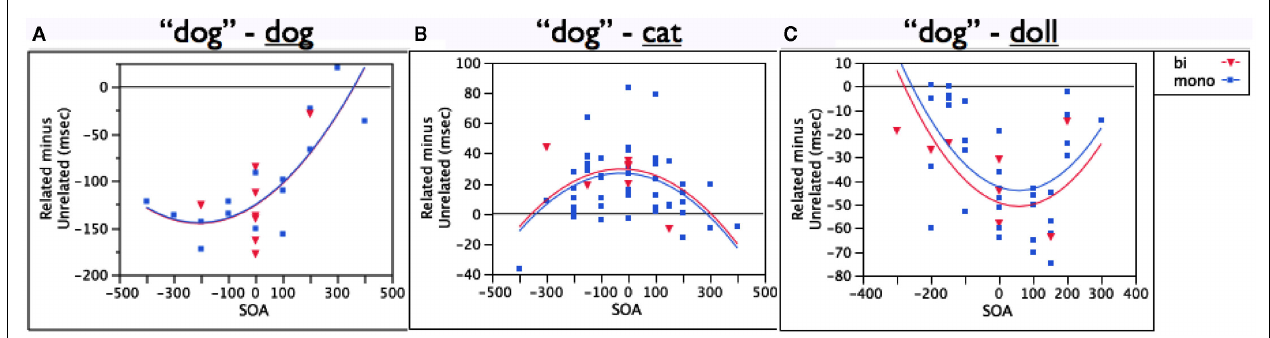
FIGURE 1 | Monolinguals and bilinguals do not differ in (A) target identity facilitation, (B) semantic interference, or (C) phonological facilitation, with target language distractors. Y -axis in all graphs represents milliseconds.